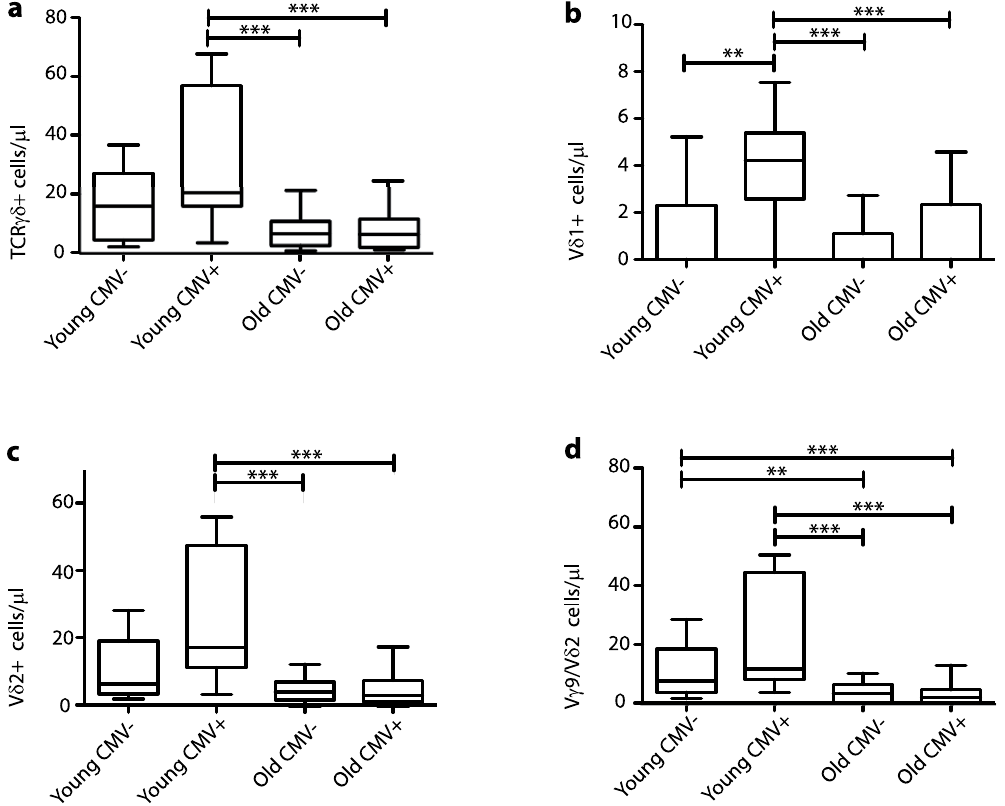
Figure 5. Effect of CMV seropositivity on V γ /V δ -usage. ( a ) Absolute numbers of total TCR γδ+ T-cells, ( b ) V δ 1 + , ( d ) V δ 2 + and ( d ) V γ 9/V δ 2 TCR γδ+ T-cells depicted as 10–90% box-whisker-plots. Significance